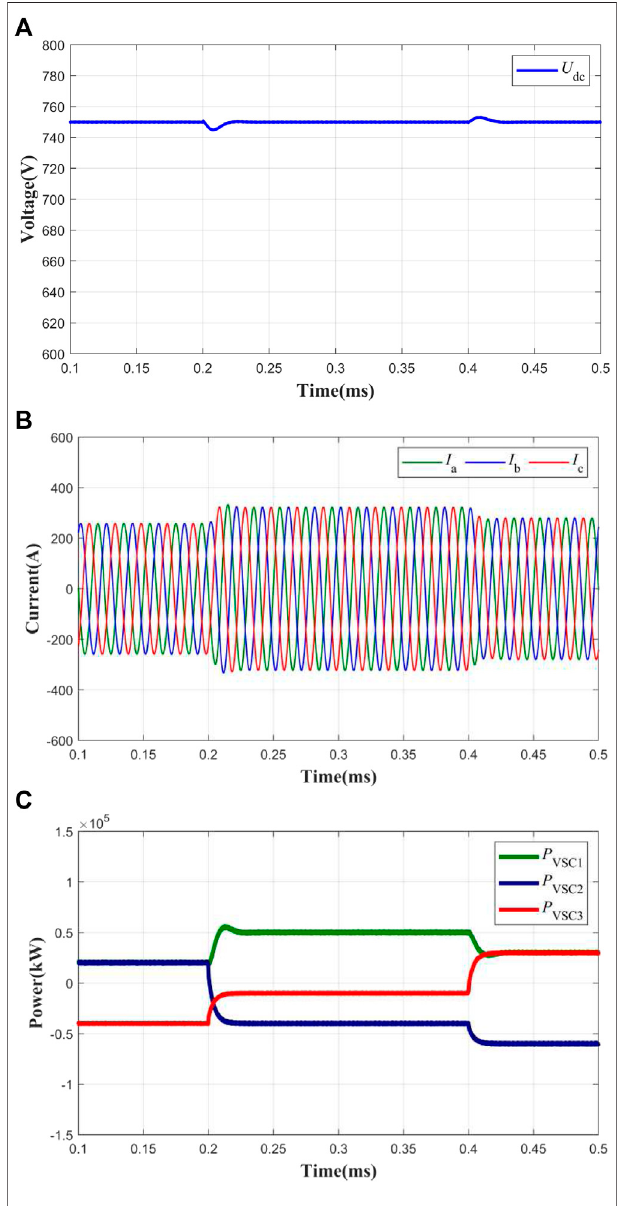
FIGURE7| Simulationwaveformoftheloadon/off. (A) SOPBusvoltage at dc side. (B) Three phase current of I a , I b , I c (Bus1as an example). (C) Active power of VSC1, VSC2,